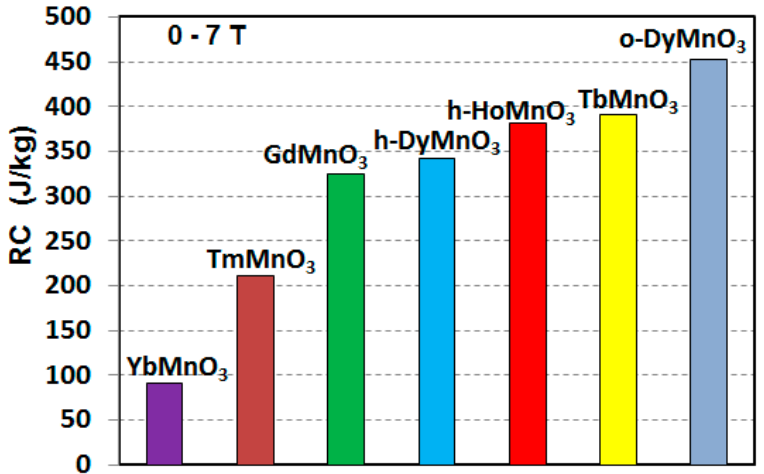
Figure 11. Refrigerant capacity of RMnO 3 single crystals under a magnetic field of 7 T applied along their easy directions, with R = Yb [26], Tm [23], Gd [87], h-Dy [22], h-Ho [27], Tb [21], and o-Dy